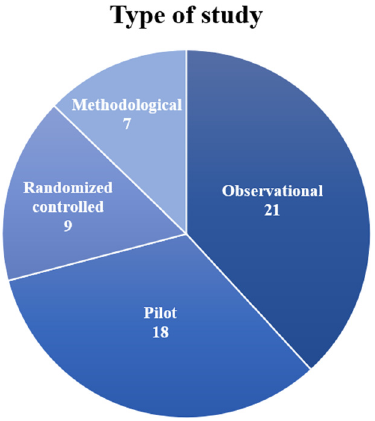
Figure 4. Pie chart portraying the number of selected studies for each study design (Observational, Pilot, Randomized Controlled, Methodological). Table 1. Type of study and aim